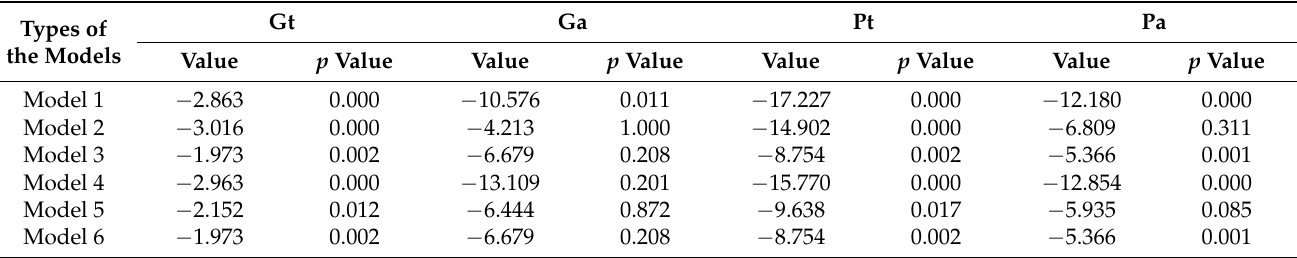
Table 5. Table 5. The results of Westerlund ECM panel cointegration tests.